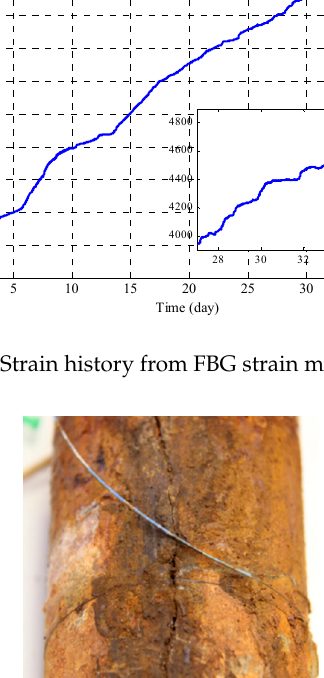
Figure 11. Illustration of cracking of the specimen.